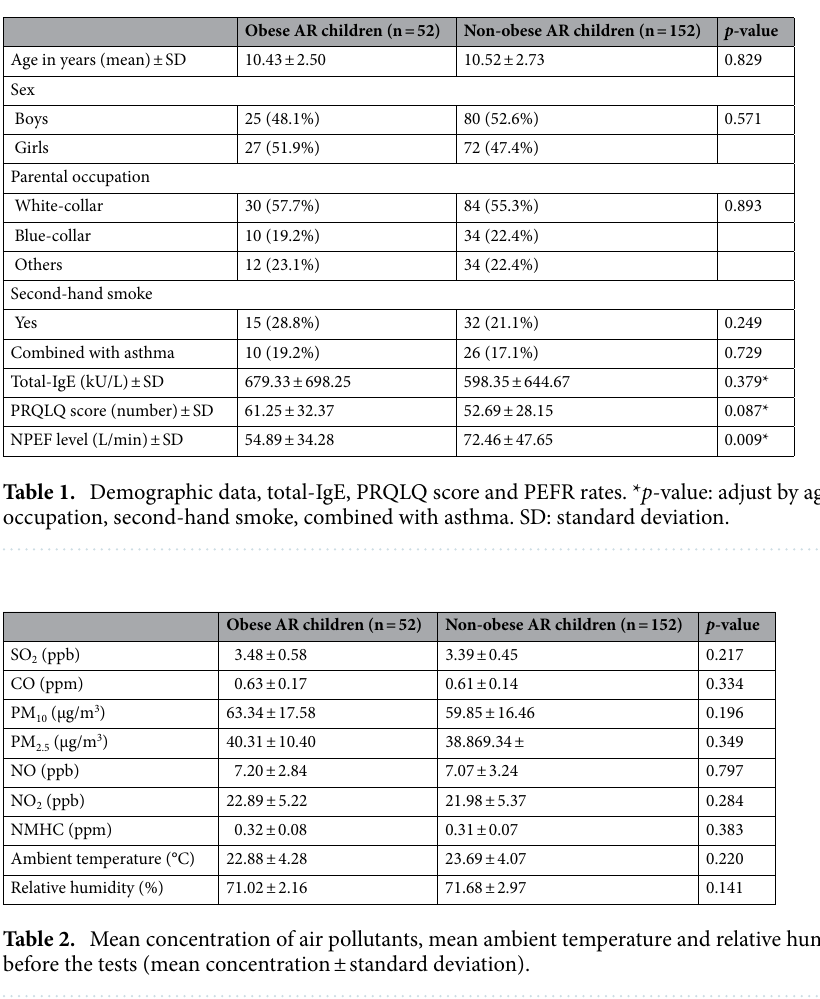
Table 2. Mean concentration of air pollutants, mean ambient temperature and relative humidity within 7 days before the tests (mean concentration ± standard deviation).